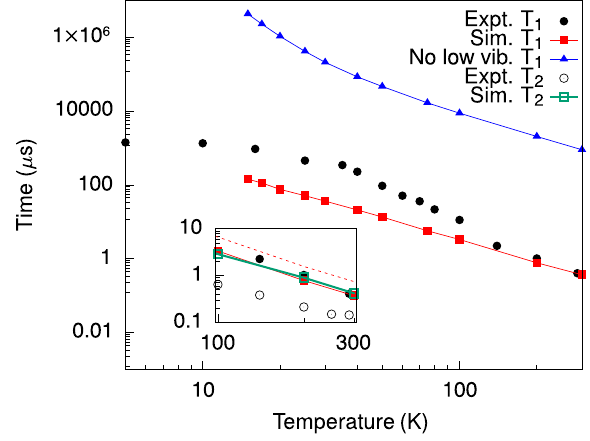
Fig. 4 | Computed spin-phononcoupling and vibrational density ofstates. The normof thelinear spin-phonon coupling coef fi cient asa functionof thefrequency of the vibration is reported in red along the negative axis in arbitrary units. The vibrational density of states is reported in black along the positive axis and in arbitrary units. The inset shows the comparison of the low-energy vibrational density of states for [VO(TPP)] (in black) and [VO(acac) 2 ] 25 (green line).